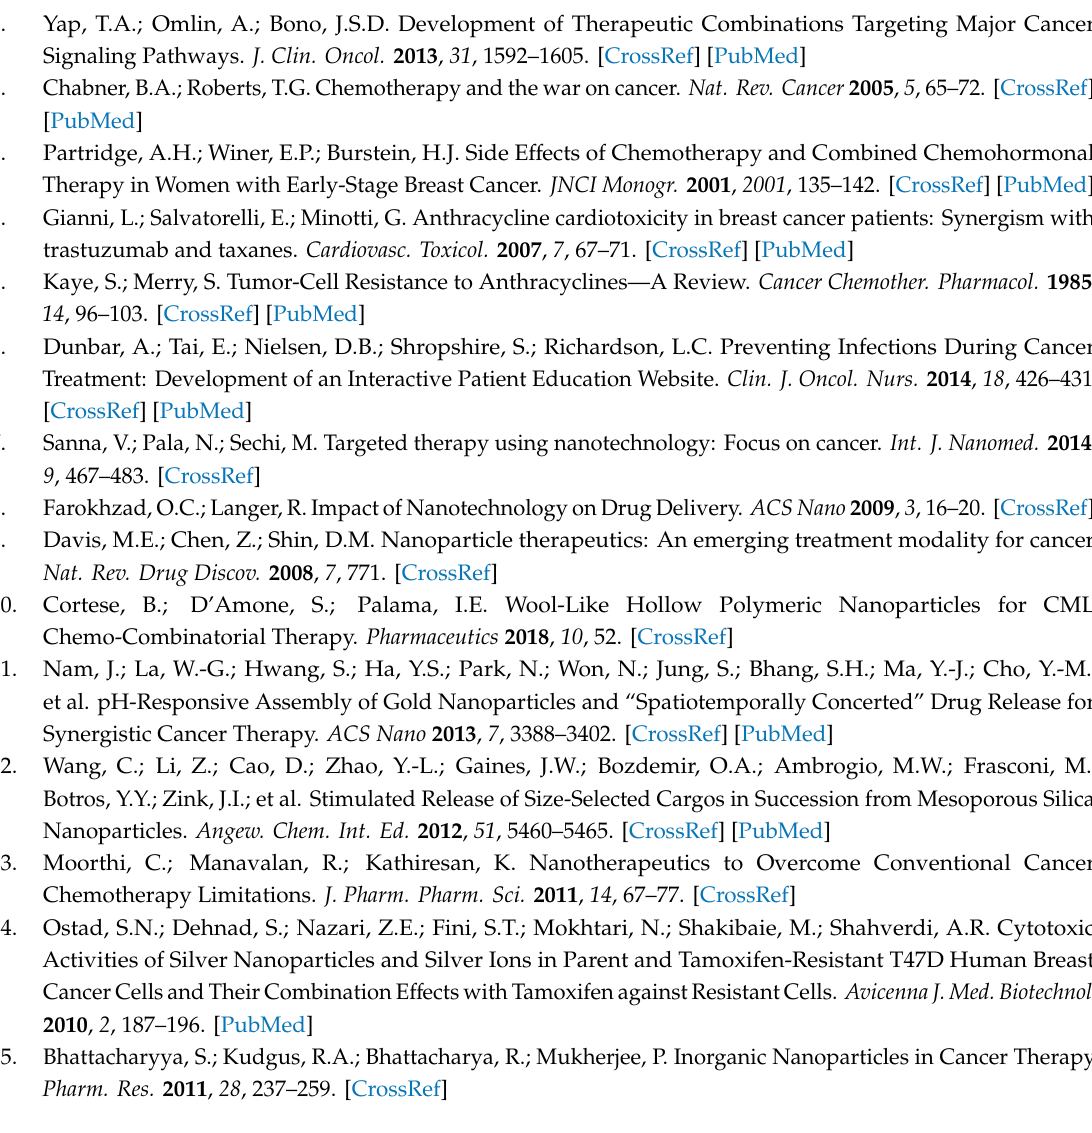
Figure S1. Absorption spectra of AgNPs. Figure S2. TEM image of AgNPs and SEM images of black PCL NPs, PCL-Ag NPs, and HC-NPs. Figure S3. FT-IR analysis of AgNPs, PCL NPs, and HC-NPs. Figure S4. FACS analysis and SDS-PAGE of non-conjugated and mAb-coated HC-NPs. Figure S5. In vitro IM and AgNPs’ cumulative release from HC-NPs. Figure S6. Hemolysis assay (HR %) of AgNPs, PCL NPs, and HC-NPs after 24 h. Figure S7. Time-dependent cellular uptake e ffi ciency of not conjugated HC-NPs with antibody. Figure S8. Cytotoxicity of free IM, AgNPs, free IM / AgNPs combination, IM-PCL NPs, and HC-NPs after 48 h toward C13895 healthy cells. Figure S9. Analysis of cell apoptosis and cell cycle of C13895 healthy cells after 24 h of treatment with di ff erent formulations.Figure S10. Cytotoxicity assay using di ff erent NP formulations in KU812 cells after 48 h of treatment. IC 50 values of NPs in KU812 leukemia cells. Figure S11. Illustration of multistep release